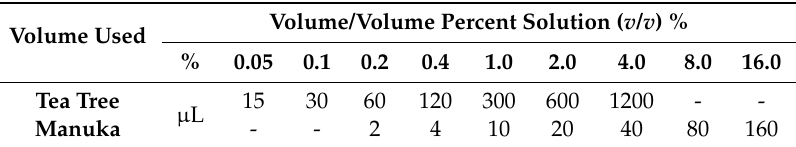
Table 4. Varying concentrations of antimicrobial solutions.